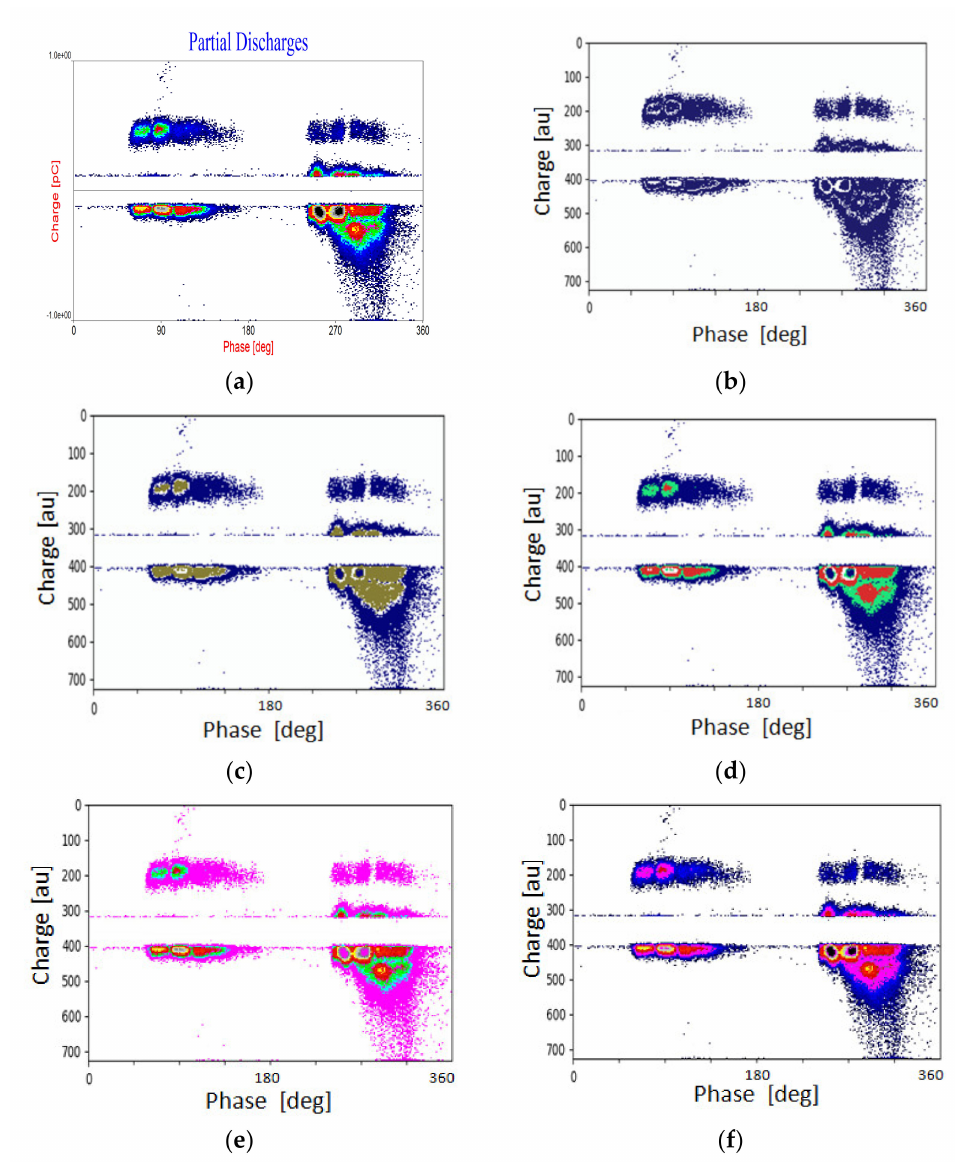
Figure 7. Segmentation of image containing discharges in HV cable insulation by K-means clustering ( a ): K = 2 ( b ), K = 3 ( c ), K = 4 ( d ). Selective highlighting (pink) of only Cluster 2 ( e ) and Cluster 3 ( f ). The case with the superimposed harmonic with the dominated DC voltage allows for the synchronization with the AC harmonic component and acquisition in the semi-AC mode (Figure 8a). The segmentation into four clusters using K-means and highlighting Cluster 2 is shown in Figure 8b. This cluster (marked in pink) corresponds to the inception of the discharges coming from the AC component superimposed on the